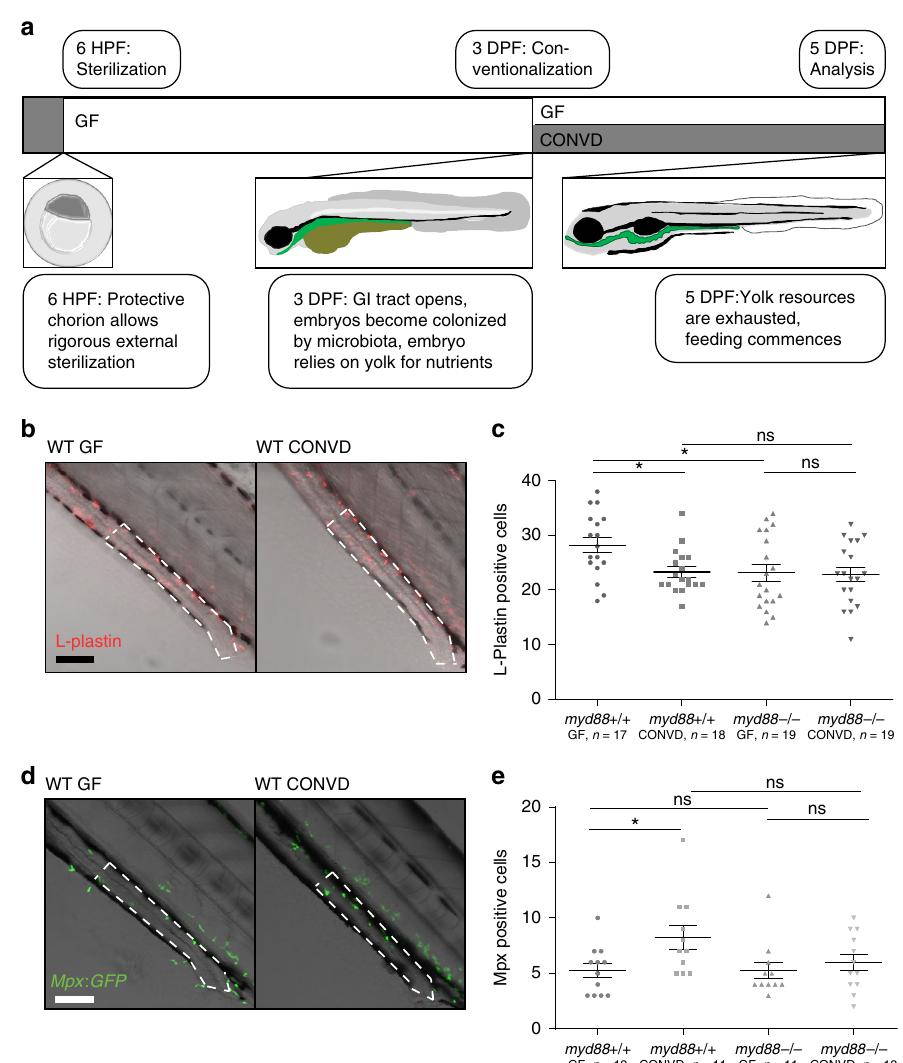
Fig. 1 Changes to immune cell composition in the gut is Myd88 dependent. a Schematic representation of the developmental features of early zebra fi sh larvae which form the foundation of this experimental approach. b Representative images of distal intestines of germ-free (GF) and conventionalized (CONVD) wildtype (WT) larvae following L-plastin staining. Composite images of bright- fi eld and L-plastin signal from confocal maximum intensity Z- projection in red. c WT larvae under germ-free conditions exhibit a signi fi cantly elevated leukocyte presence in the distal intestine, compared to conventionalized. This elevated leukocyte presence was no longer detectable under the same conditions in myd88 de fi cient larvae. Figure is representative of three independent replications. d Representative live microscopy images of distal intestine of GF and CONVD larvae of the Mpx:GFP reporter zebra fi sh line. Bright- fi eld overlaid with confocal maximum intensity Z-projection in green. e Germ-free larvae exhibit signi fi cantly reduced neutrophil in fi ltration in the distal intestine compared to conventionalized larvae. No signi fi cant difference was observed in myd88 de fi cient backgrounds. Figure is made from pooled data from three biological replicates. b , d an area of intestine extending 4 somites proximal to the cloaca, representing the area of counting, is outlined in white dashed lines. scale bars represent 100 µ m. c , e each data point represent cell counts from one larvae based on confocal z-stacks acquired at 20 times magni fi cation. Error bars represent standard error of the mean. * P ≤ 0.05 by two-way ANOVA with Bonferroni correction for